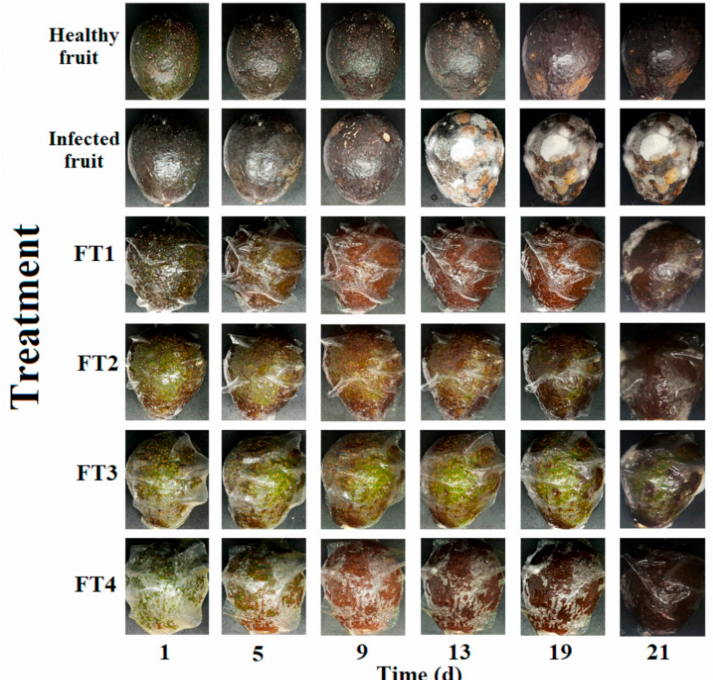
Figure 2. Qualitative effect of the hybrid films FT1–FT4 on soft rot symptom emergence of in avocadoes triggered by Clonostachys rosea .